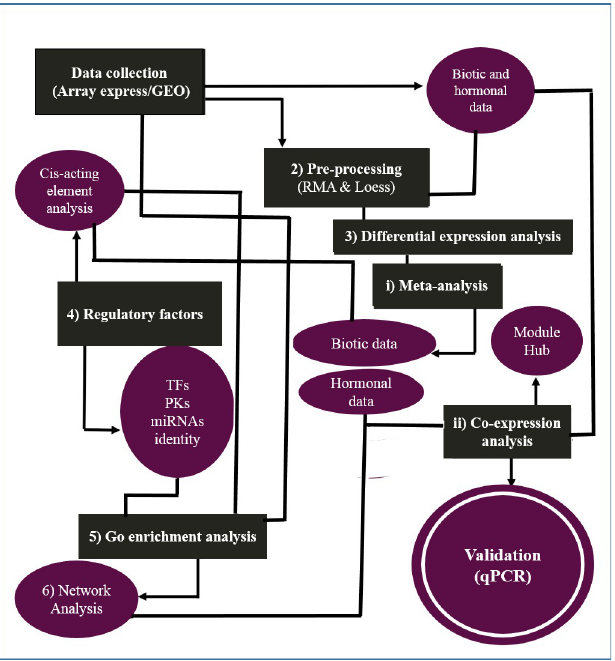
Fig 1. Schematic overview of the integrative strategy for understanding aspects of response of barley transcriptome to biotic and hormonal stresses.